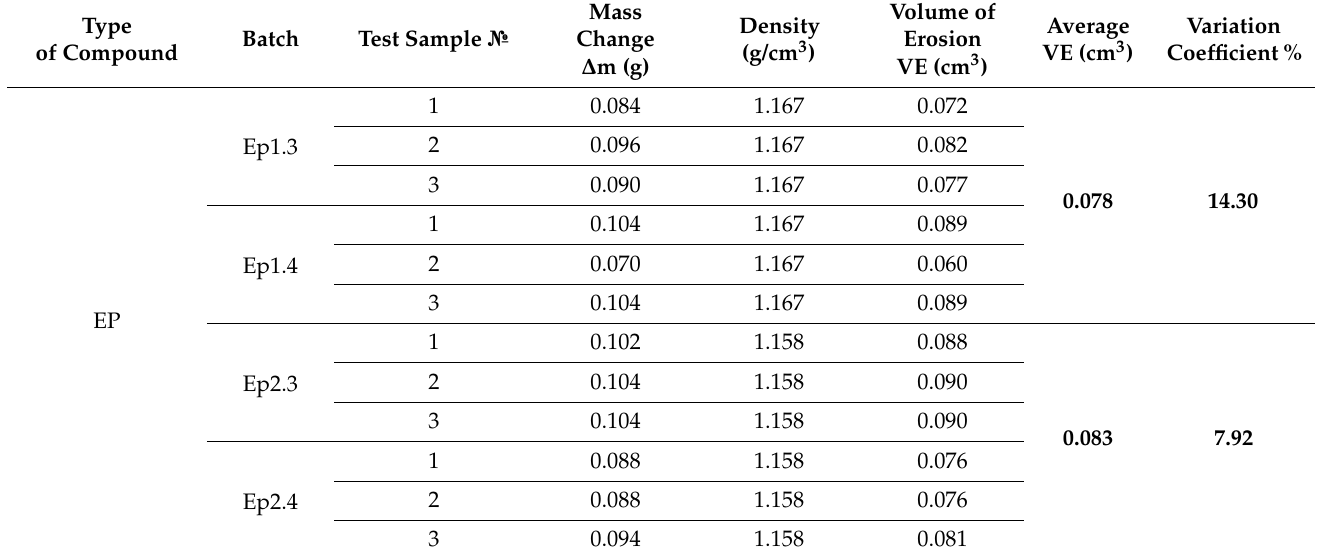
Table A6. Wear of unfilled epoxy binder (EP) at 180 ◦ C at an impingement angle of 45 ◦ .